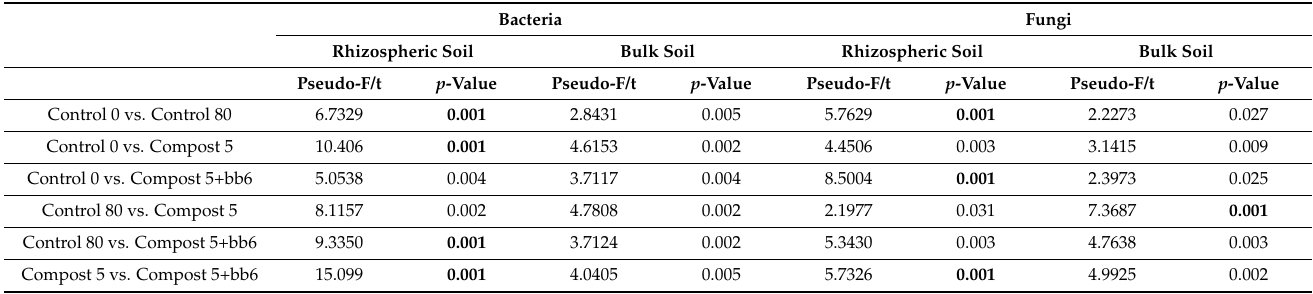
Table 6. Results of PERMANOVA significance test across treatments within each type of soil in bacte- rial and fungal communities. Treatment and soil were used as fixed factors (number of permutations: 999). The test of significance was based on Bray–Curtis similarity values. The significance level was fixed for p -value equal to 0.001 (significance p -values are in bold). Bacteria Fungi Rhizospheric Soil Bulk Soil Rhizospheric Soil Bulk Soil Pseudo-F/t p -Value Pseudo-F/t p -Value Pseudo-F/t p -Value Pseudo-F/t p -Value 6.7329